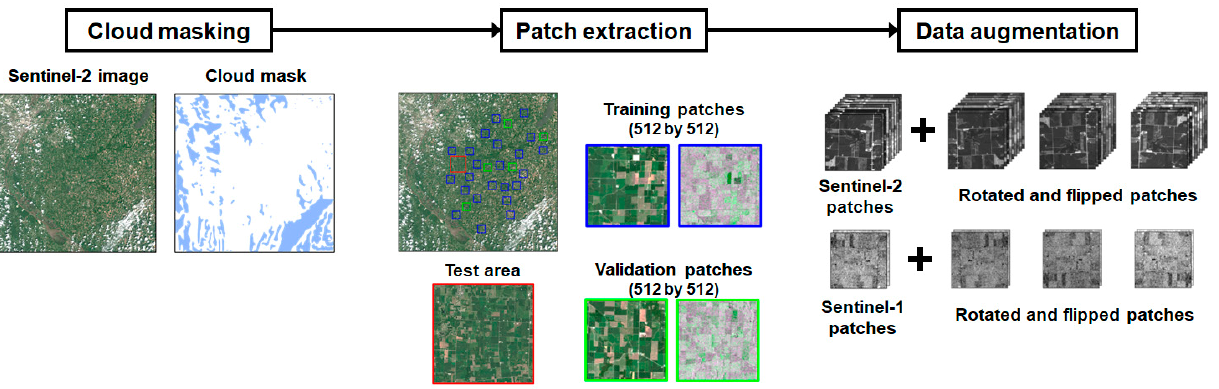
Figure 5. Workflow for the preparation of paired training patches employed in this study. Not all training and validation patches are shown in this figure.